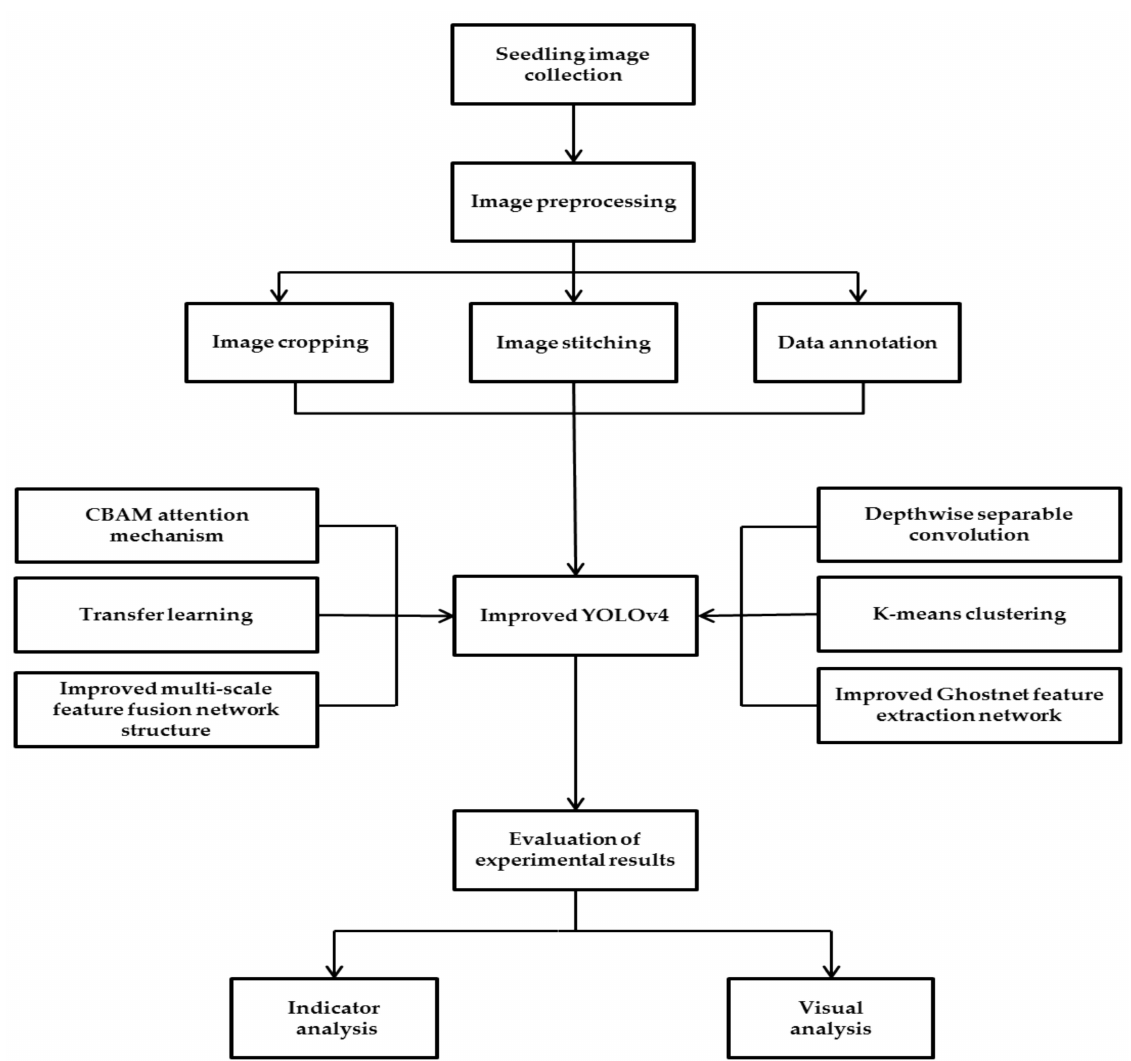
Figure 8. Flow chart of seedling number